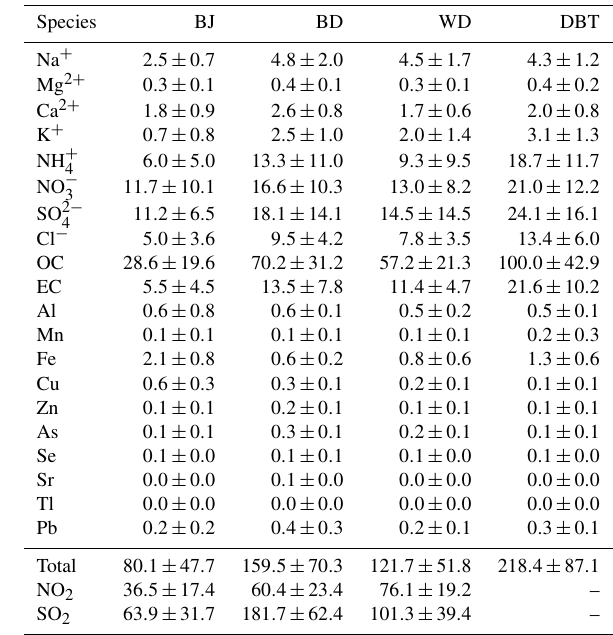
Table 2. The average mass concentrations (Mean ± SD) of PM 2 . 5 species, NO 2 and SO 2 at the four sampling sites during the sam- pling period in the winter of 2015 (µgm − 3 ).